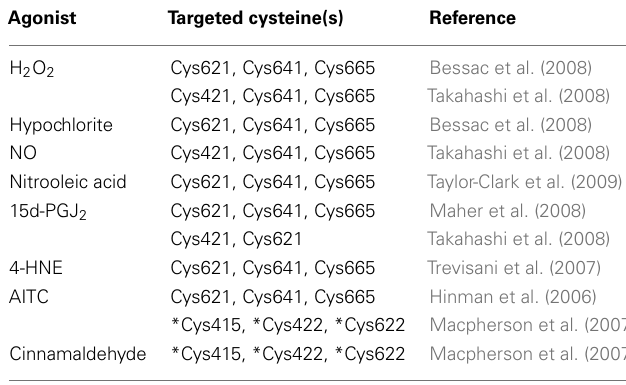
Table 1 |Targeted cysteine residues in